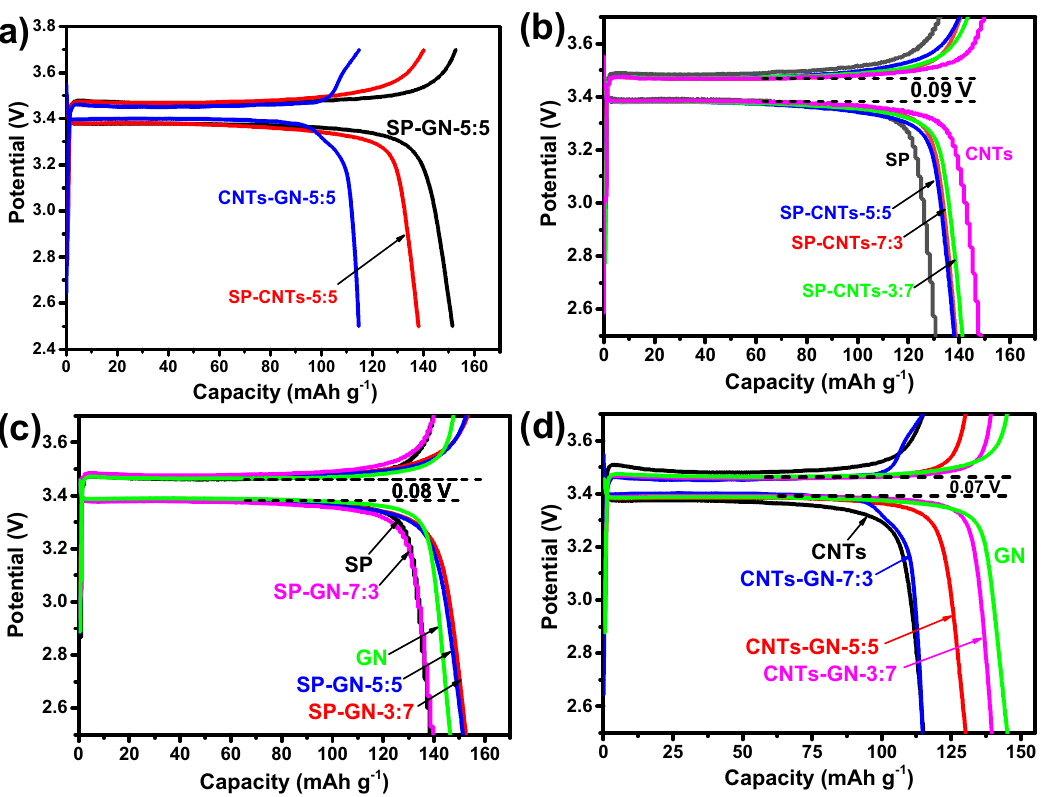
Figure 6: Typical galvanostatic charge/discharge pro fi les of the LiFePO 4 electrodes with ( a – d ) various binary conductive agents in di ff erent ratios at 1 C between 2.5 and 3.7